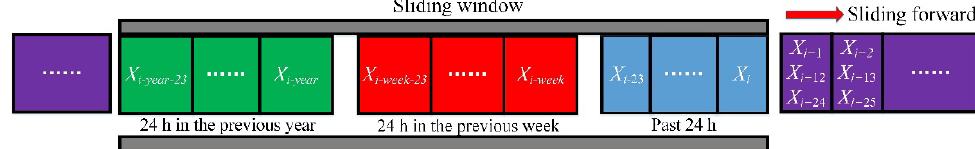
Figure 7. The structure of a time-discontinuous sliding window.